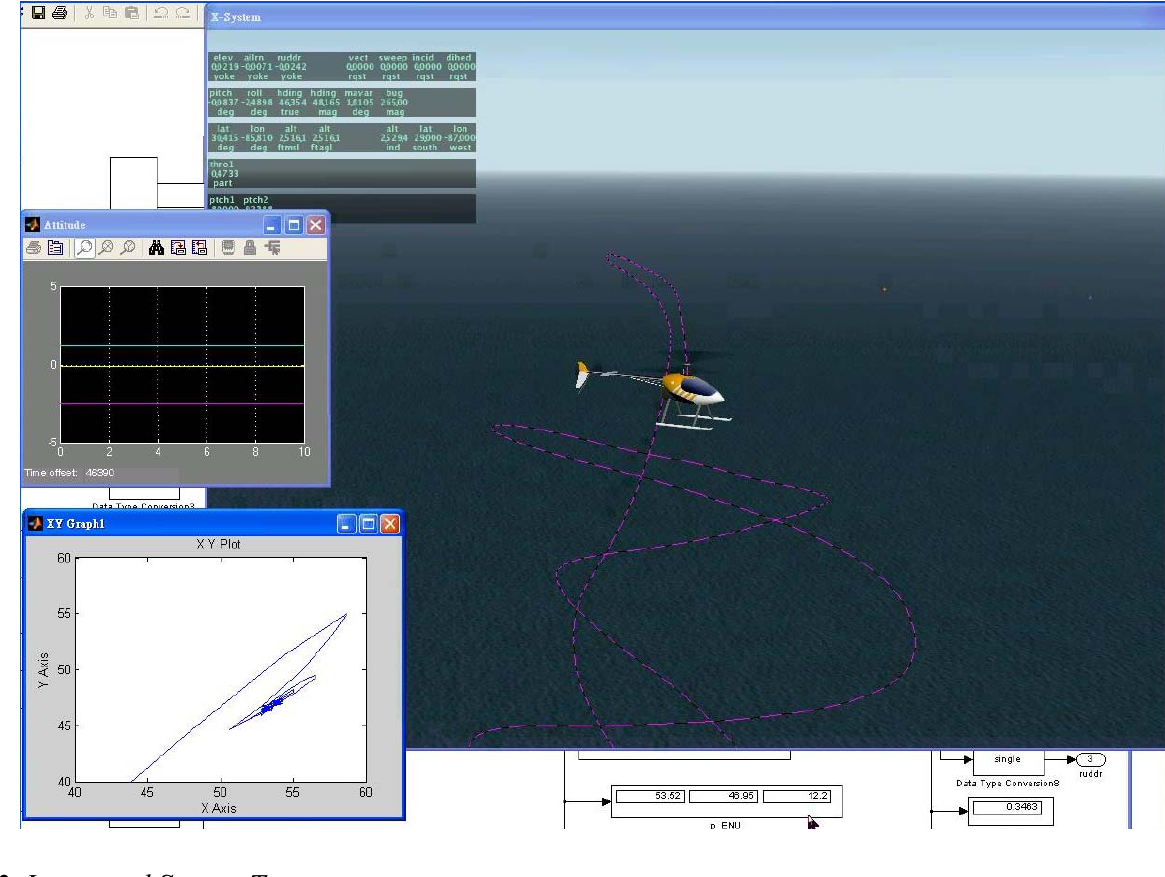
Figure 20. The FCS directs the unmanned helicopter to (50, 50, 30), where the main sub-figure is X-Plane, and two sub-figures on left are the FCS real time monitors to show the attitude and trajectory in the East-North horizontal